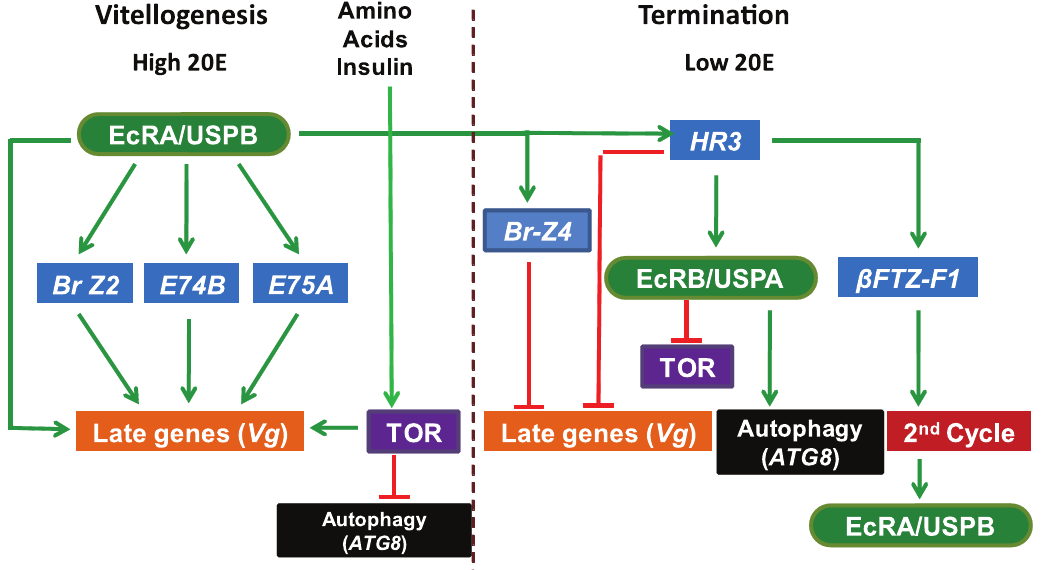
Figure 9. A schematic representation of the 20E regulated events during the first vitellogenic cycle in the fat body of the mosquito A.aegypti . After a blood meal activation, a high level of 20E acts via EcRA/USPB heterodimer activating early genes, BrZ2, E74B and E75A, which synergistically activate late genes such as Vg [15–18]. TOR, activated by amino acids and insulin, is essential for activating late genes [3,6]. TOR is also involved in inhibition of the programmed autophagy during vitellogenesis [19]. HR3 is inhibited by E75A [18], but activated by EcRA/USPB ensuring its timely expression. At the termination time, lowering of the 20E titer results in repressive action of BriZ1 (not shown) and BrZ4 on late genes such as Vg [15,17]. In this study, we have shown that HR3 is involved in inhibition of late target genes expression ( Vg ). On the other hand, HR3 activates the EcRB/USPA heterodimer. EcR has been shown to repress TOR and activate autophagy [19]. We postulate that it is the EcRB/USPA heterodimer that is responsible for these functions mediating action of HR3; however, this link requires additional confirmation. HR3 acts as an activator of betaFTZ-F1 that in turn is essential for maintaining cyclicity of egg development. The green ovals – EcR/USP 20E heterodimeric receptor; blue boxes – genes that encode 20E regulated transcription factors (early genes); purple boxes – Target-of Rapamycin; black boxes – autophagy; orange boxes – late target genes. Green arrows depict activating effects and red lines - repressive effects. The basics of the scheme were adapted from [46]for comparison